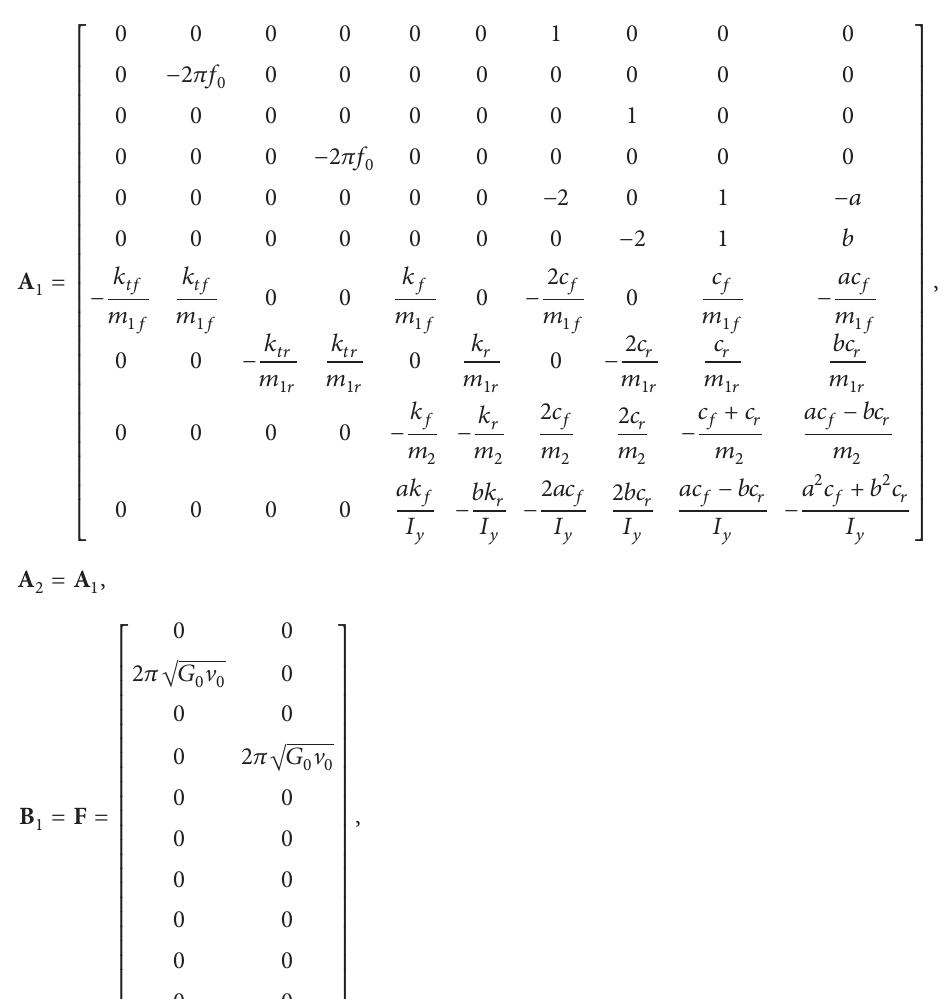
where W is the input matrix of white Gaussian noise expressed as the input matrix W = [𝑤 1 𝑤 2 ] matrix of the active suspension expressed as U = [𝑢 𝑓 𝑢 𝑟 ] and C is a 10 × 10 dimension unit